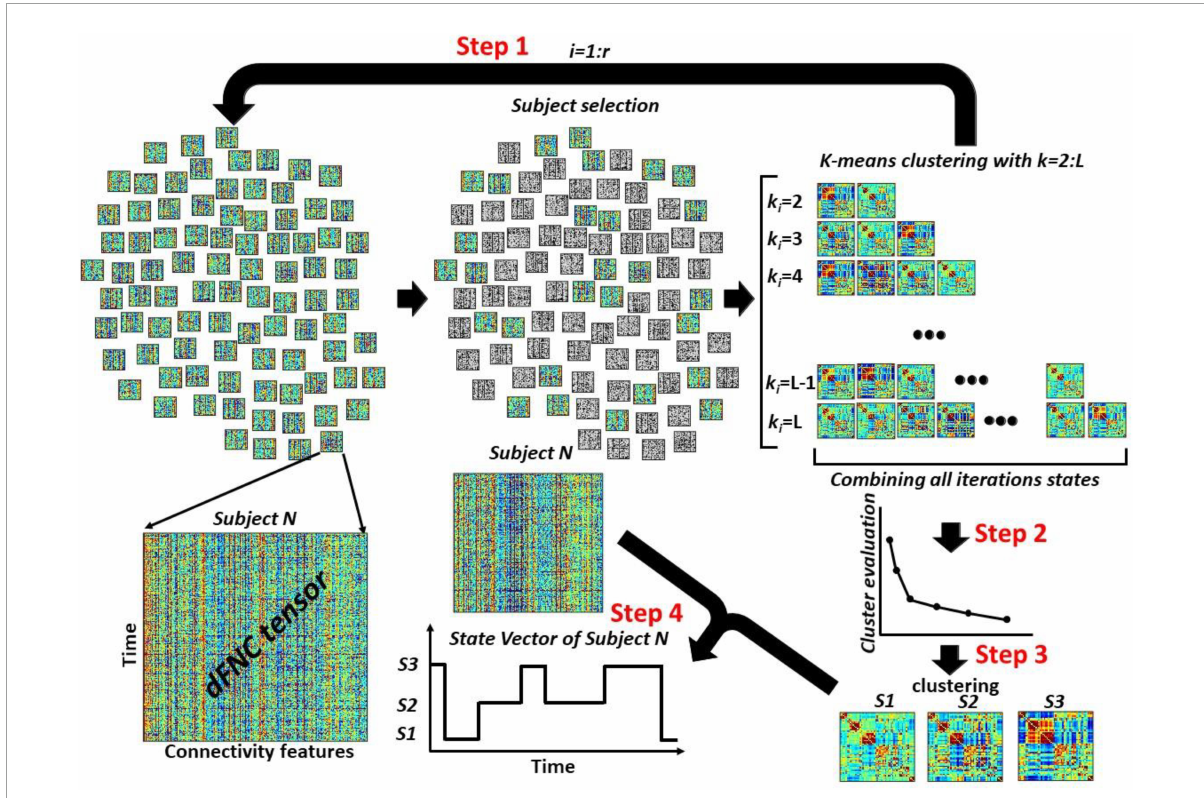
FIGURE3 The overview of the proposed dFNC pipeline for dFNC state estimation. In Step 1, we select a subsample of dFNC tensor and then used kmeans clustering with k -values from 2 to L and put them into ( L ( L + 1 ) 2 − 1 ) . With r iteration, we would have r ( L ( L + 1 ) 2 − 1 ) clusters centroids in total. In Step 2, concatenated all cluster centroids and we use elbow criteria to find the best k -values, called K opt hereafter. In Step 3, using another kmeans clustering approach, we estimated the final dFNC states. In Step 4, we used this final states and found the state vector for each